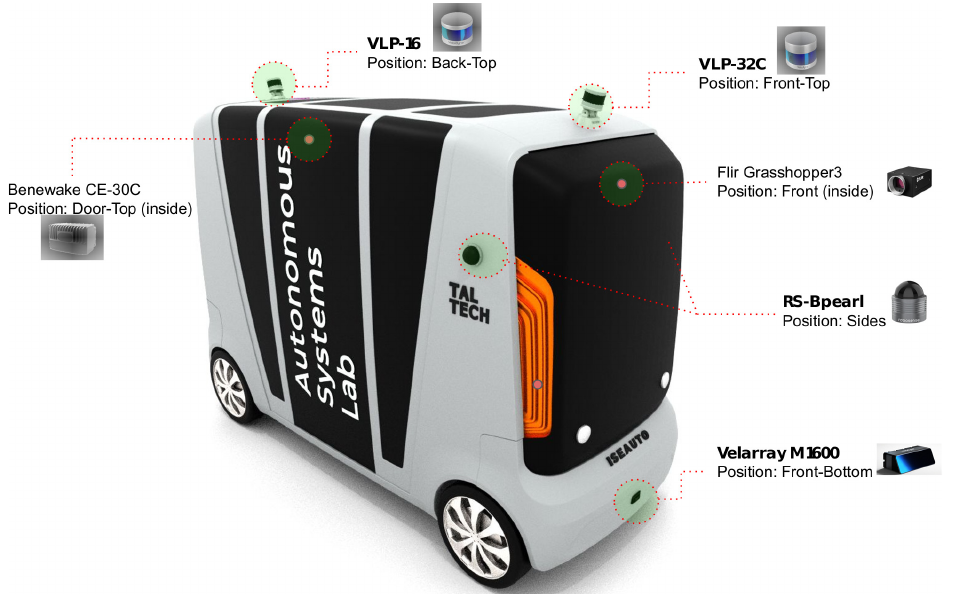
Figure 1. Perceptive sensors layout. The Benewake CE-30C LiDAR is located inside the shuttle and attached on top of the